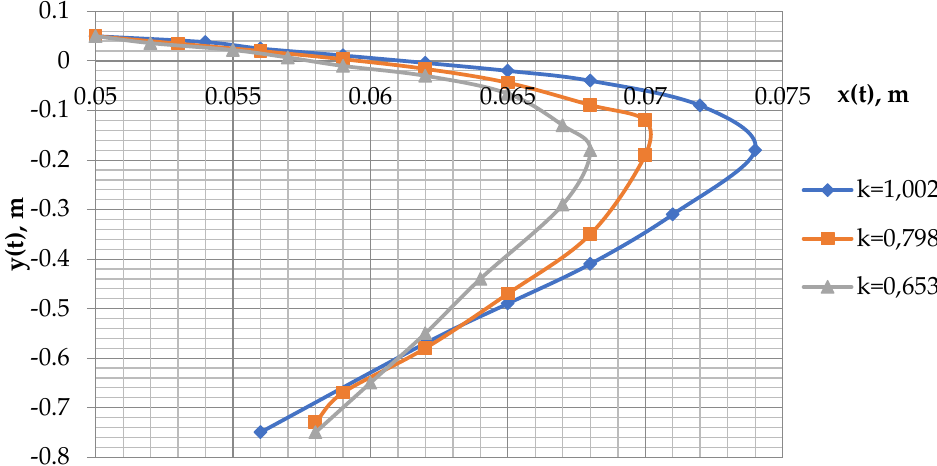
-0.8 Figure 3. Dependence of the particle motion at a speed of rotation of n = 1500 min − 1 .